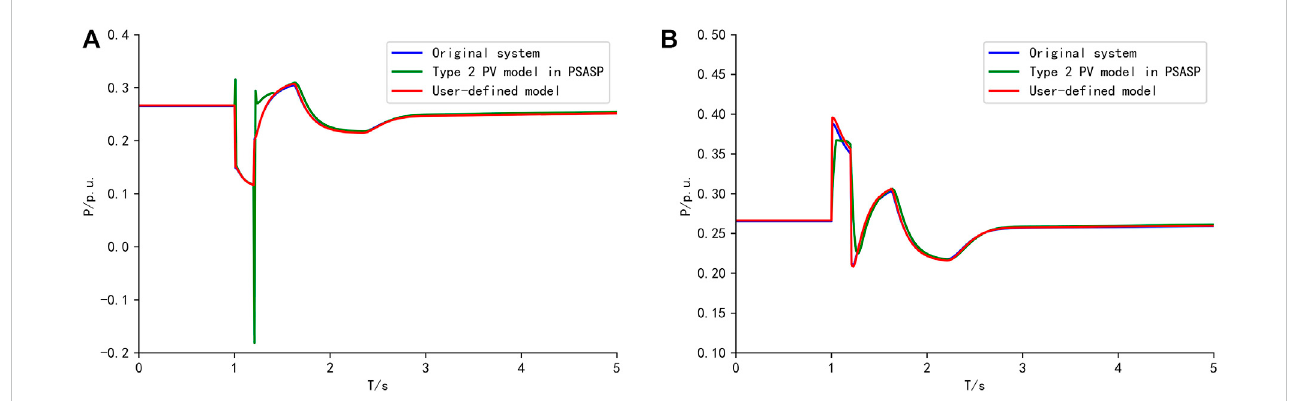
FIGURE 6 Comparison of equivalent results. (A) Fault 3, (B) Fault